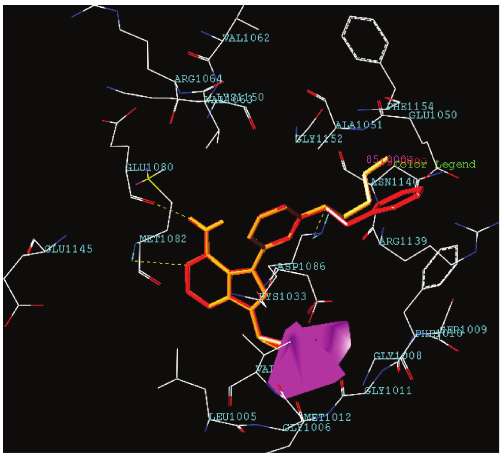
Figure 6: CoMSIA H-bond acceptor map with the most (red) and least (orange) active compound within the active